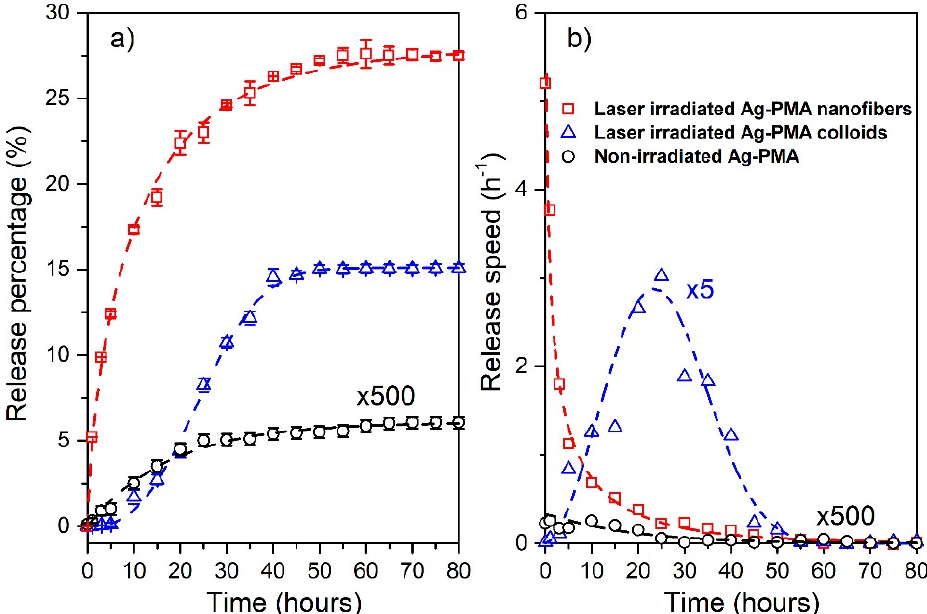
Figure 7. The release percentage vs. time and the corresponding best-fit performed with the use of the Weibull CDF (Equation (1)) (dashed lines) are reported in panel ( a ). The Weibull PDFs corresponding to the release data and fitted curves are reported in panel ( b ). Data for the non-irradiated system, referred to both colloids and nanofibers, are multiplied by a factor 500. The release speed data for the irradiated colloids are multiplied by a factor 5. In Figure S3 of Supplementary Materials, we include the comparison with the irradiated PMA samples that show no significant release performances.